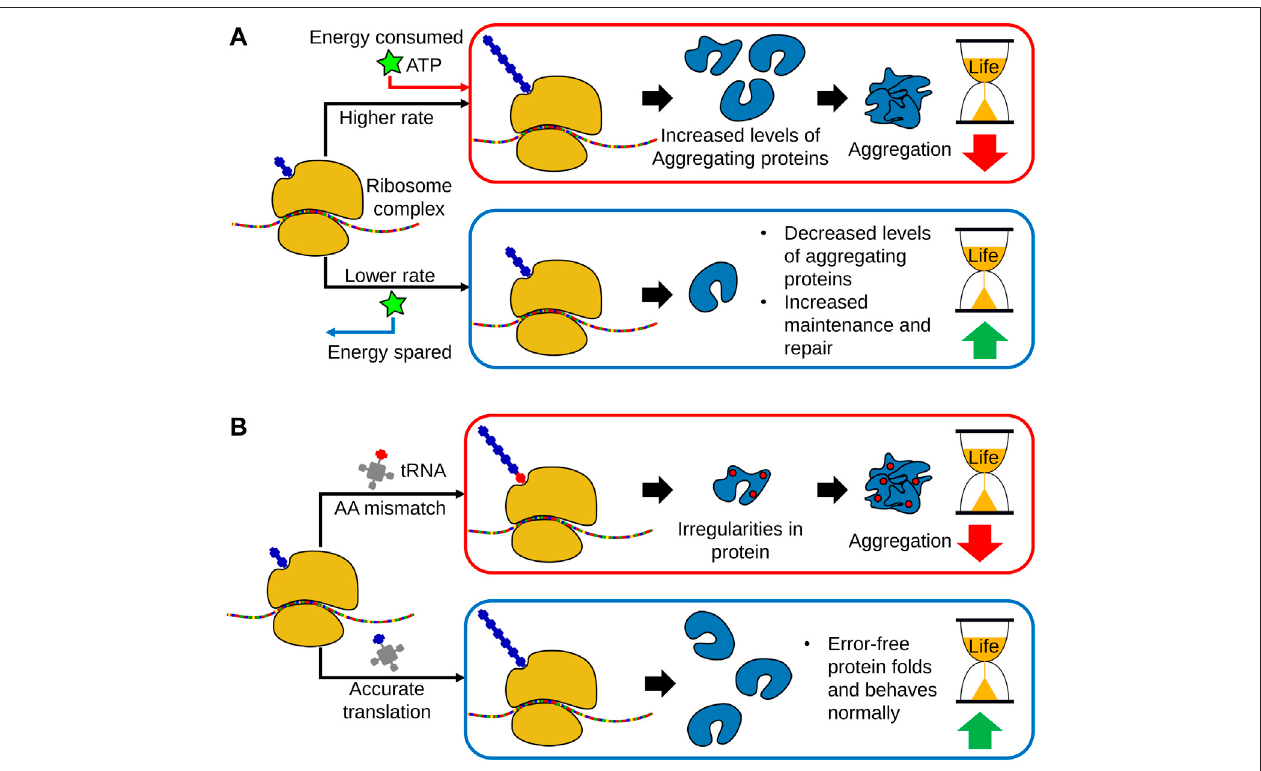
FIGURE 2 | The links between translational regulation and aging. (A) With age, global translational rates decrease in a broad range of organisms, indicating a link betweenlossofproteinsynthesiscapacityandaging.However,translationisahighlyenergyconsumingprocessandgrowingevidenceindicatesthatadeclineinprotein synthesisallowsagreaterallocationofmetabolicenergytowardscellularmaintenanceandrepair.Subsequently,adecreaseinproteintranslationpromotesproteostasis and leads to lifespan extension. Moreover, lowering protein translation also decreases the production of aggregation prone-proteins. (B) In addition to global translational rates, translational fi delity may also decline with age, leading to increased amino acid misincorporation, as well as erroneous start and stop codon readthrough. This results in the production of dysfunctional proteins and peptides, thereby increasing the accumulation of protein aggregates. As such, accurate translation is necessary for organismal homeostasis and long lifespan.